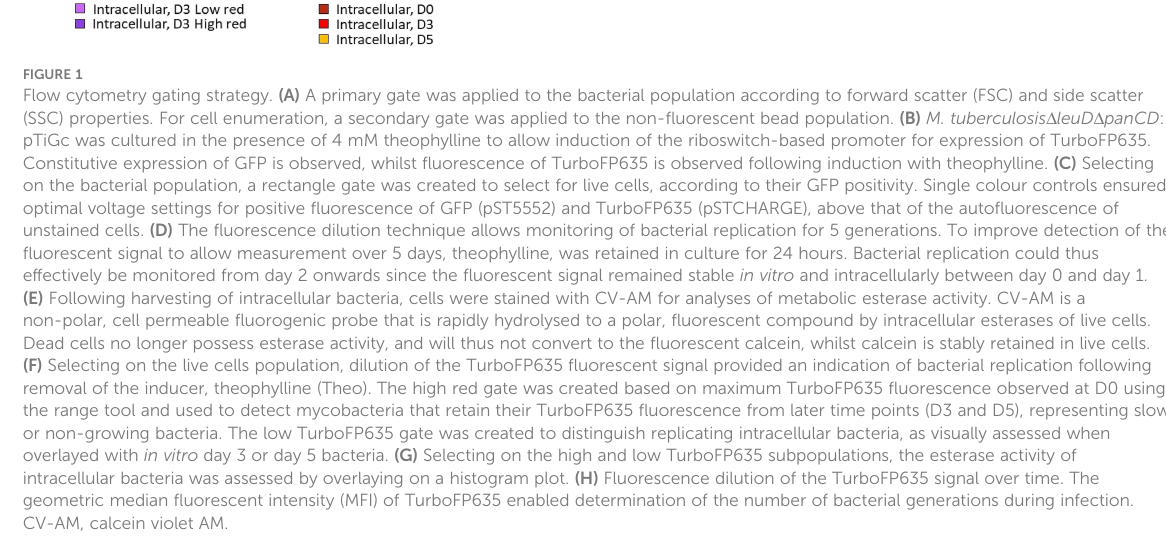
μl (i.e. 5x10 5 beads) was added to selected samples. The number of reference beads recorded by fl ow cytometry was used to enumerate bacterial populations using the following formula (Adapted from ThermoFisher Scienti fi c, 2004):